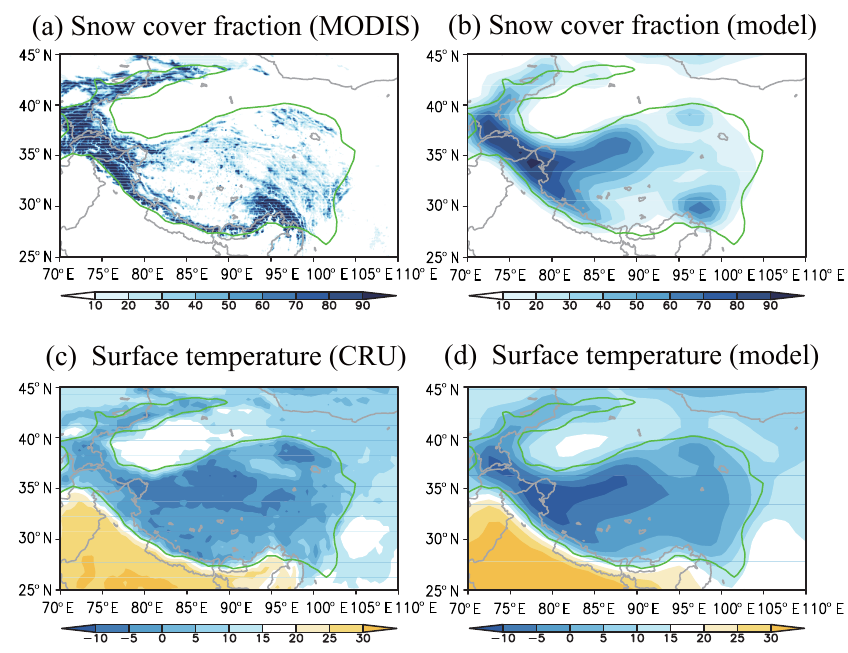
Figure 4. Spatial distribution of the MAM averaged (a) snow cover fraction (%) derived from MODIS for 2002–2012 and (c) surface temperature ( ◦ C) from CRU for 1979–2012, compared with the simulated MAM averaged (b) snow cover and (d) surface temperature for 20 model years over Tibetan Plateau. The green outlined area indicates the plateau above 2500m. Table 2. The March–April–May (MAM) averaged dust emissions (Tg per season), transport (gm − 1 s − 1 ), dry deposition (Tg per season) and wet deposition (Tg per season) over the eastern Asian dust source area (75–115 ◦ E and 25–50 ◦ N) in Case1, Case2 and Case3, as well as the corresponding differences between these three